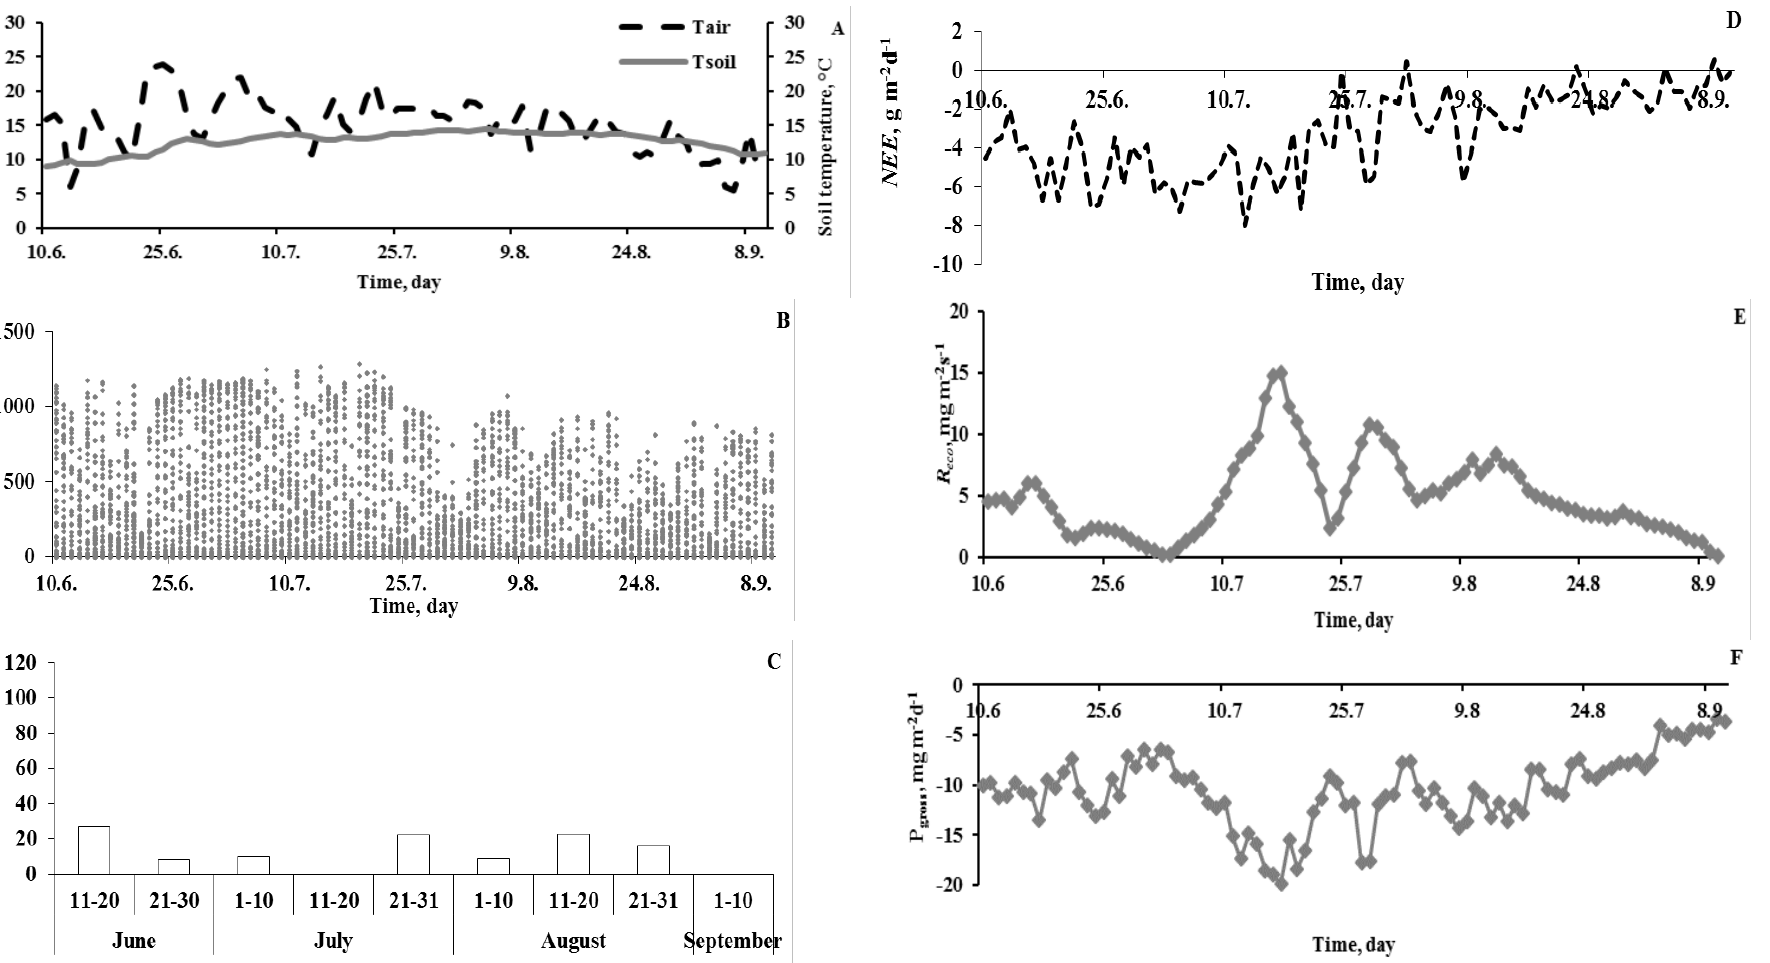
Figure 3. Meteorological conditions and CO (°C); B: PAR intensity (μmol m -2 s -1 ); C: precipitation (mm; each column shows the cumulative rainfall in one-third of a month); D: NEE (g m -2 d -1 ); E: R d -1 ); F: P (g m -2 d -1 gross